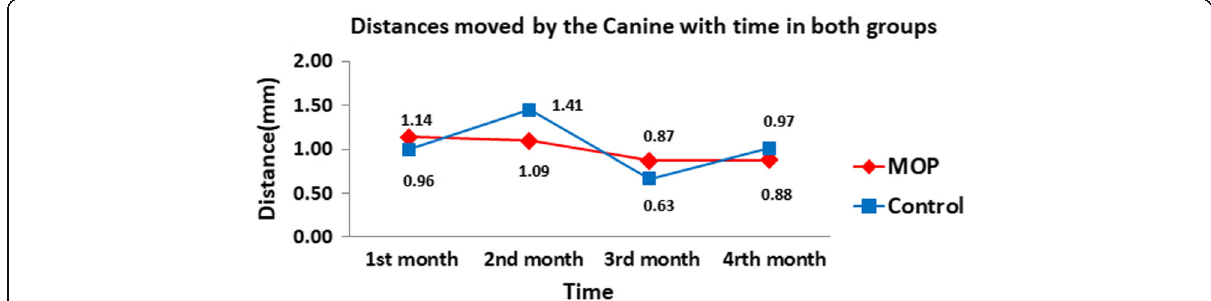
Fig. 5 Time line chart representing the mean distances moved by the upper canines along the study time in the control and MOP